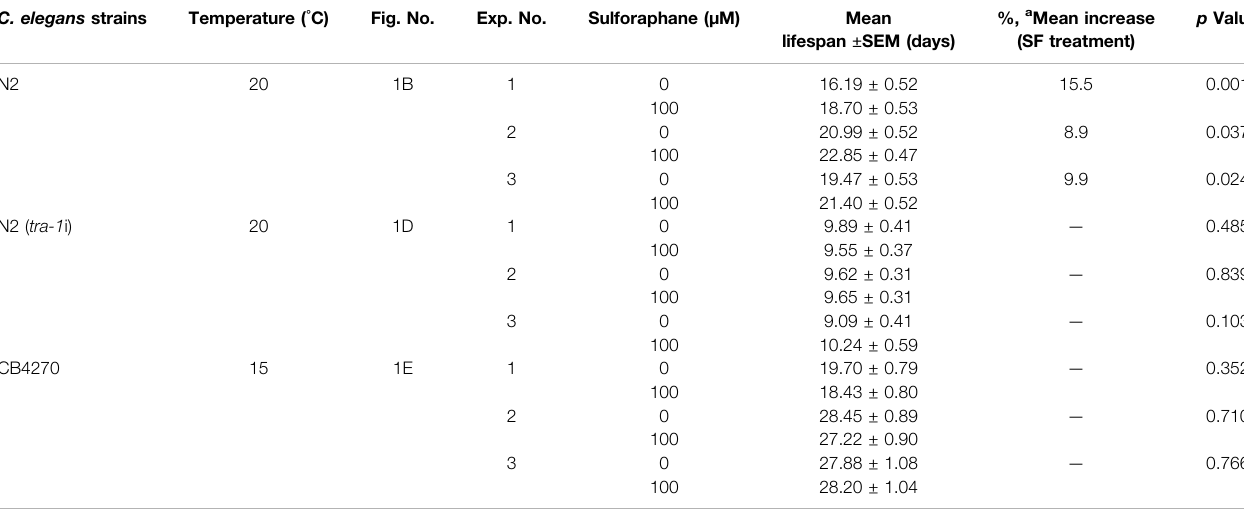
a Mean lifespan: Corresponds to the mean lifespan as measured in the present study. Summary and statistical analysis of sulforaphane effects on lifespan experiments. N2: Wild-type C. elegans strain; N2 ( tra-1 i): loss-of-function tra-1 C. elegans strain; CB4270: tra-1 ( − ) mutant C. elegans strain. The mean lifespan values were analyzed by log-rank (Kaplan – Meier) statistical tests. p values < 0.05 were considered statistically signi fi cant. p values were calculated for individual experiments ( n (cid:1) 100). All statistical evaluations were calculated using SPSS 25.0. ( − ) not calculated because the standard deviation was > 0.05. SEM: standard error of the